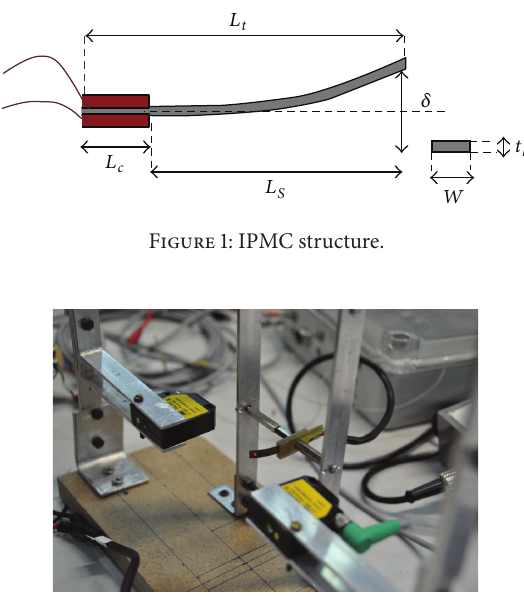
Figure 2: Experimental setup: mechanical structure, IPMC mem- brane, and laser beam.